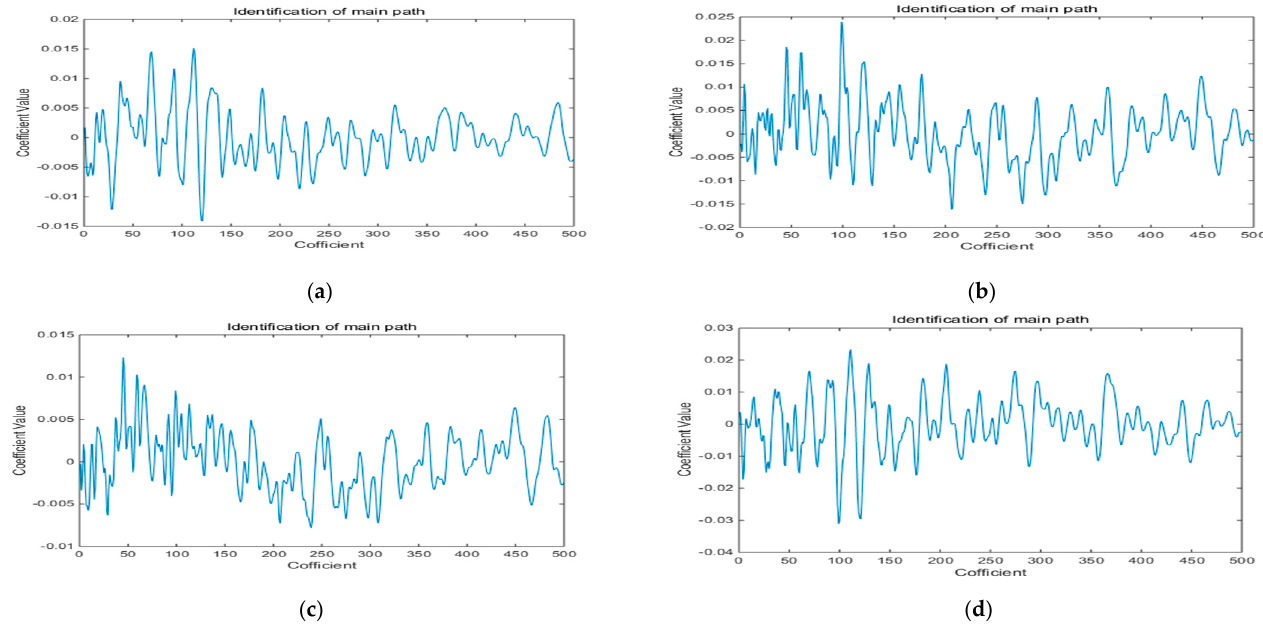
Figure 8. Identification process in primary paths. ( a ) Identification of ˆ P p 1 ( n ) ; ( b ) identification of ˆ P p 2 ( n ) ; ( c ) identification of ˆ P p 3 ( n ) ; ( d ) identification of ˆ P p 4 ( n )